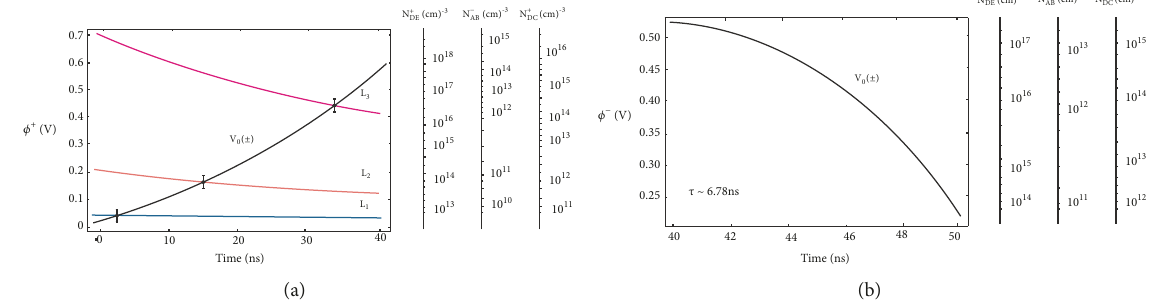
Figure 7: Dynamical behavior of the transistor action at 𝐼 𝐶 = 90𝑚𝐴 and 𝑉 𝐵𝐸 = 0.85𝑉